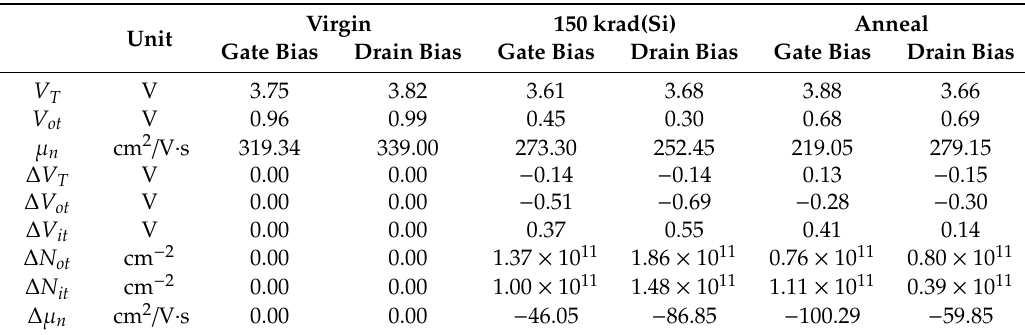
Table 2. Extracted parameters for device